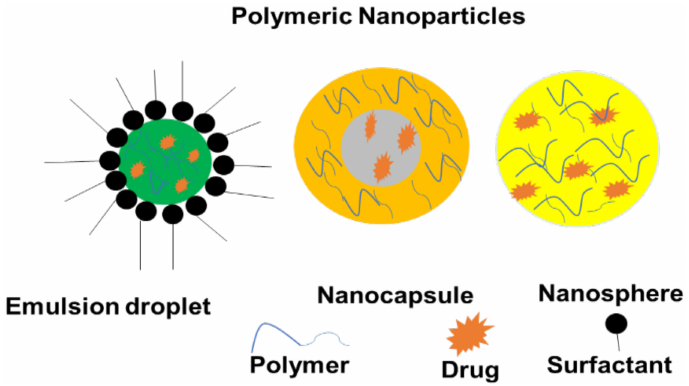
Figure 4. Polymer-based